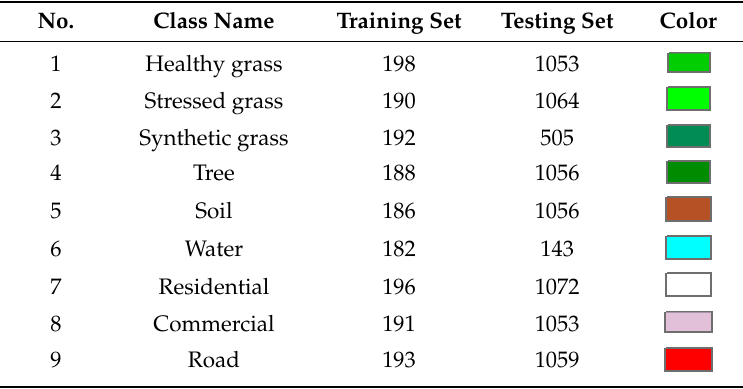
Table 1. Details of training and testing samples for classification.